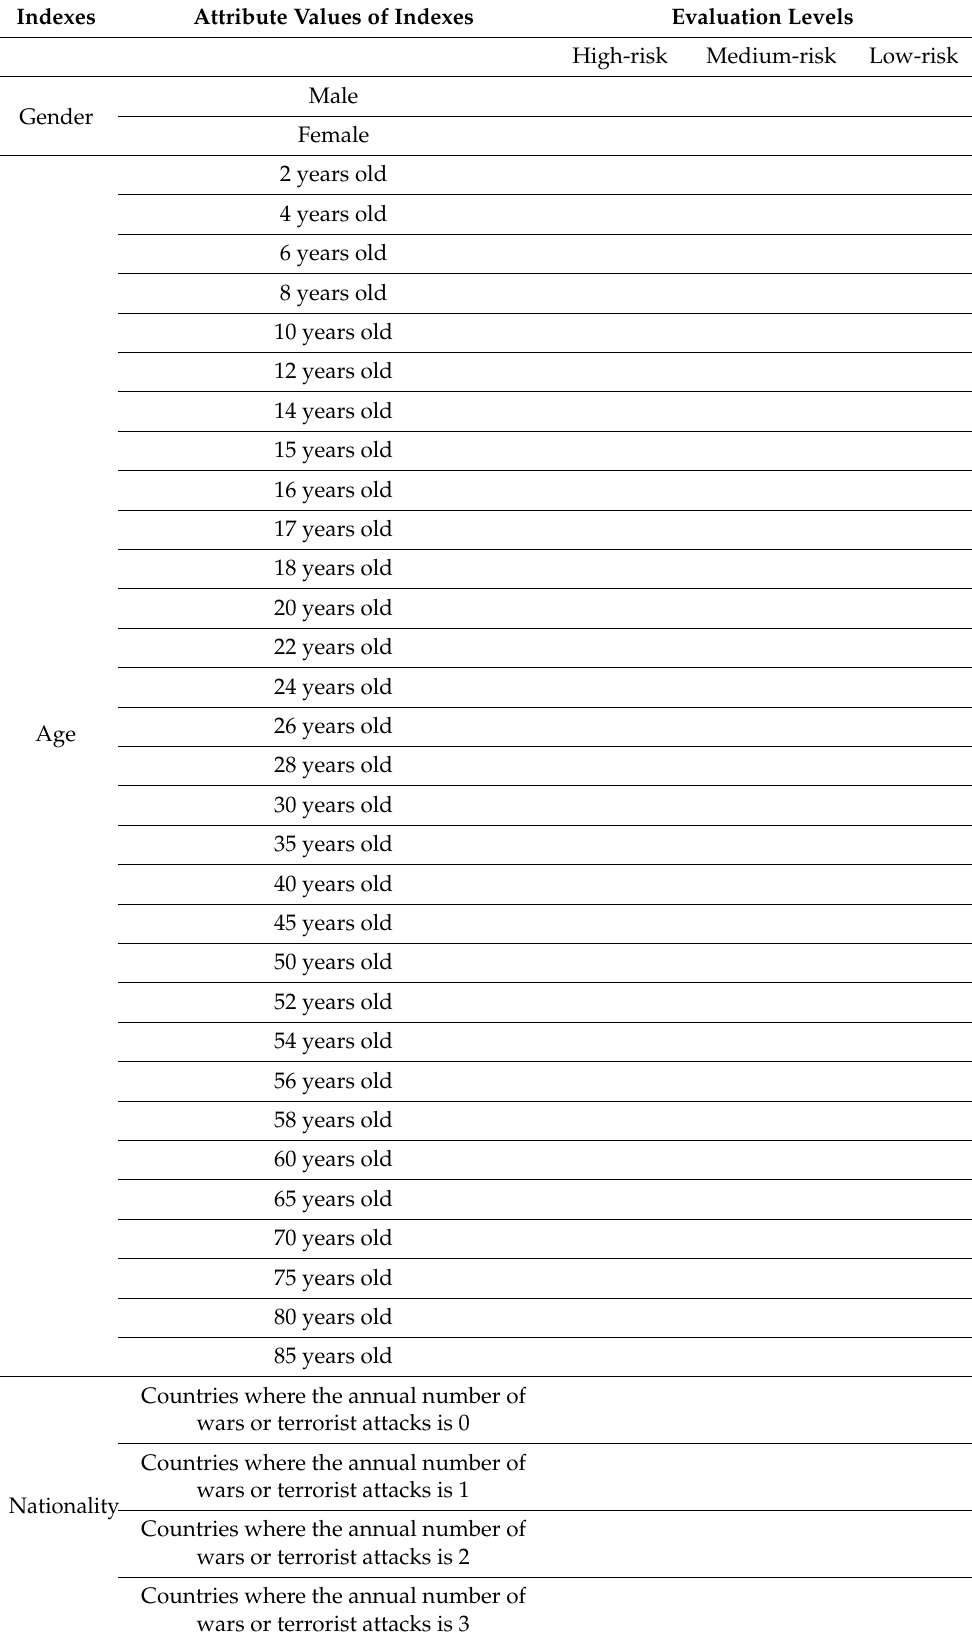
Table A7. Single factor evaluation of basic background